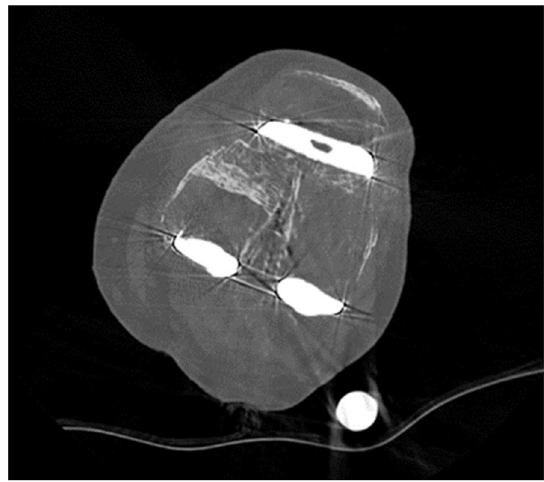
Fig. 2 CT slice of the same level after